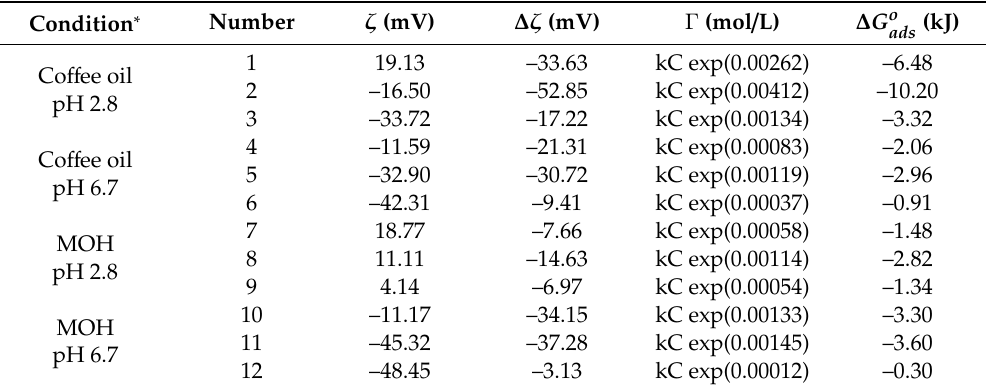
Table 3. The results of di ff erent parameters at pH 2.8 and 6.7 under various